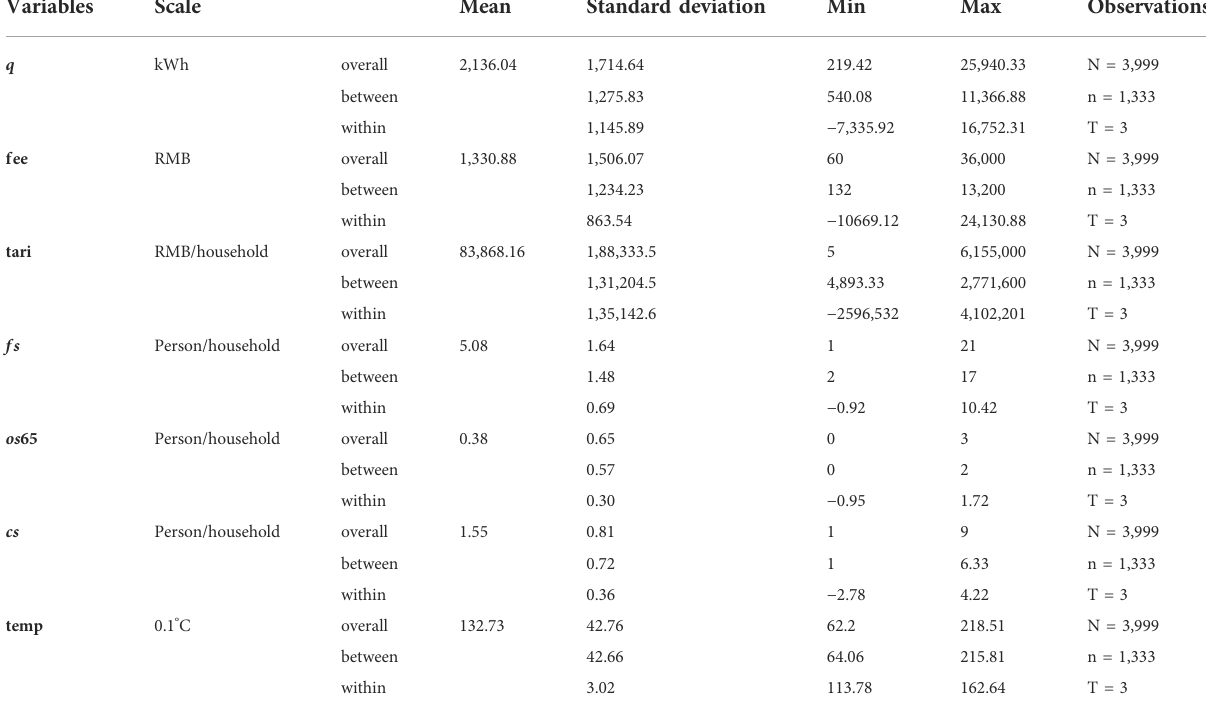
TABLE 2 Descriptive statistics of the data.